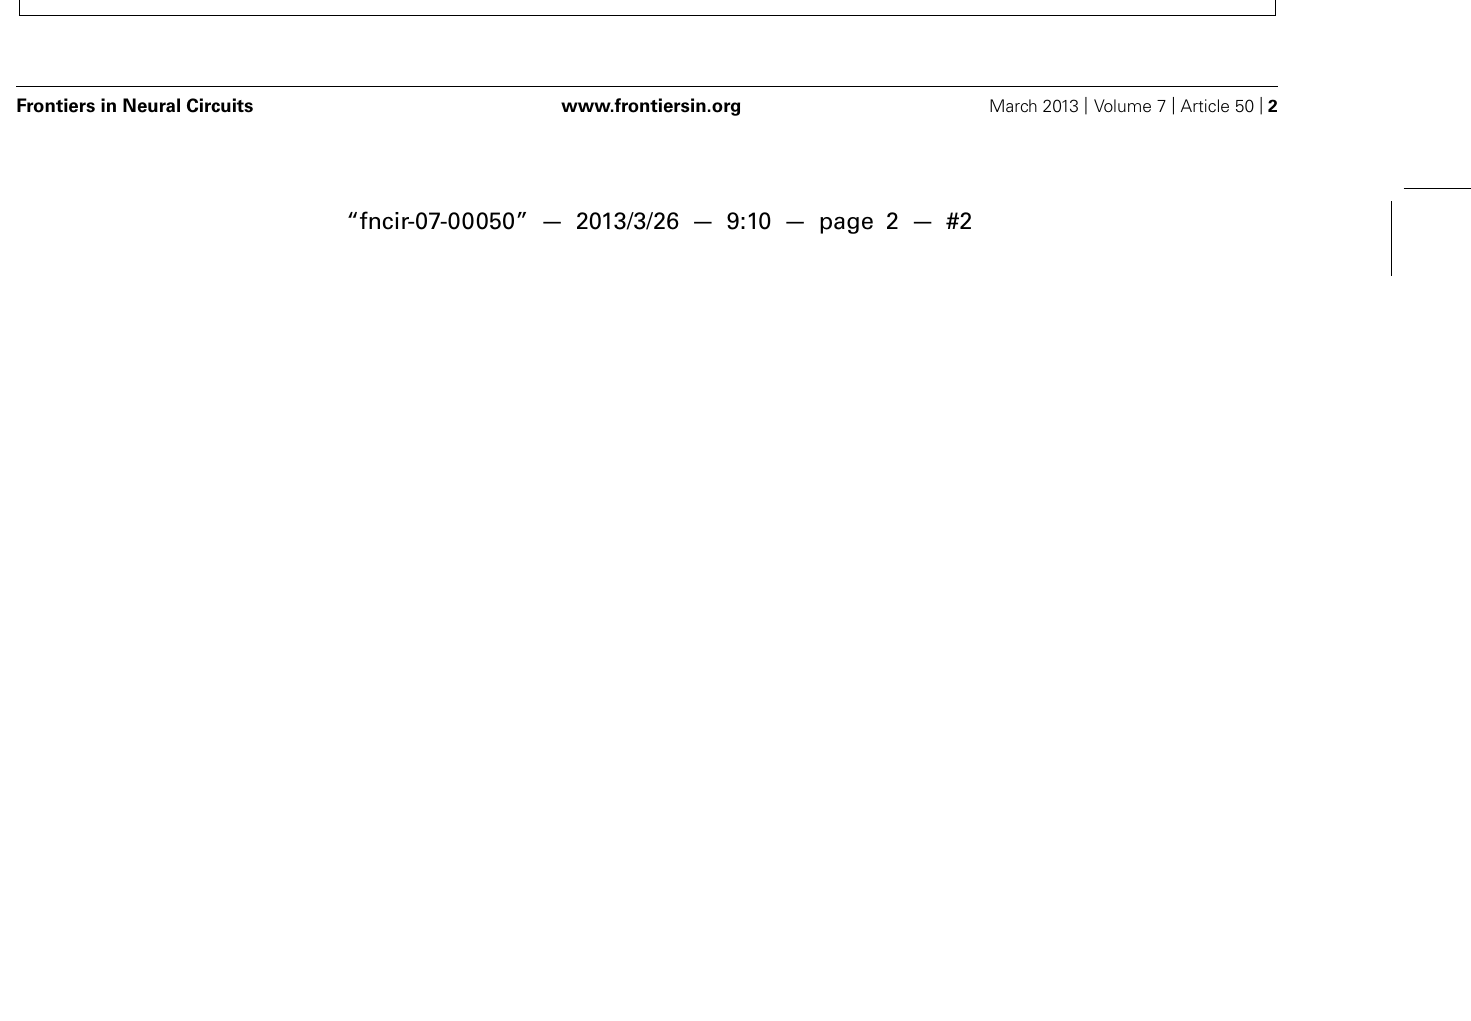
the rotation of the robot. (B) Block diagram of the closed-loop FRI. Relative motion between the turn-table and the robot, ω p - ω r , caused spiking in the H1-cell.The responses of the H1-cell (instantaneous spike rate F ), were used by a controller to compensate for externally generated turntable movements, by driving the robot in the opposite direction. (C) The F2E convertor maps F onto the control input E. The piece-wise sigmoid functions, based on which E was used to update the robot speed V r . (modified from Ejaz etal.,